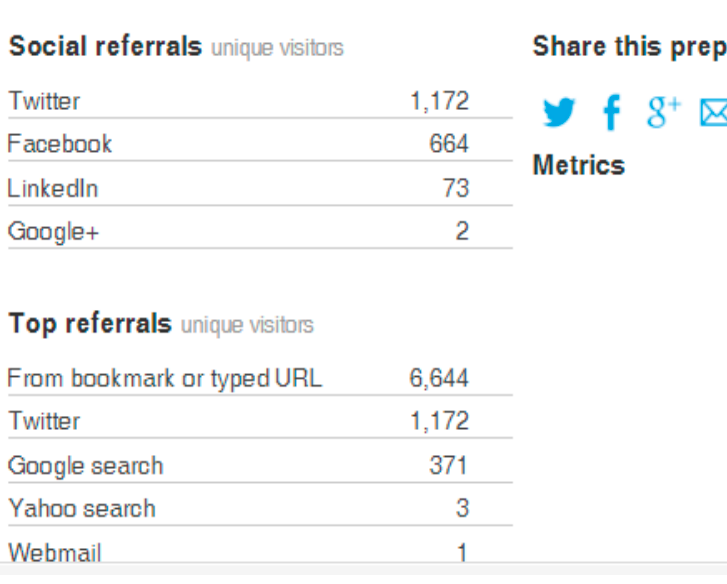
Figure 2. An example of article level metrics at PeerJ Preprints.